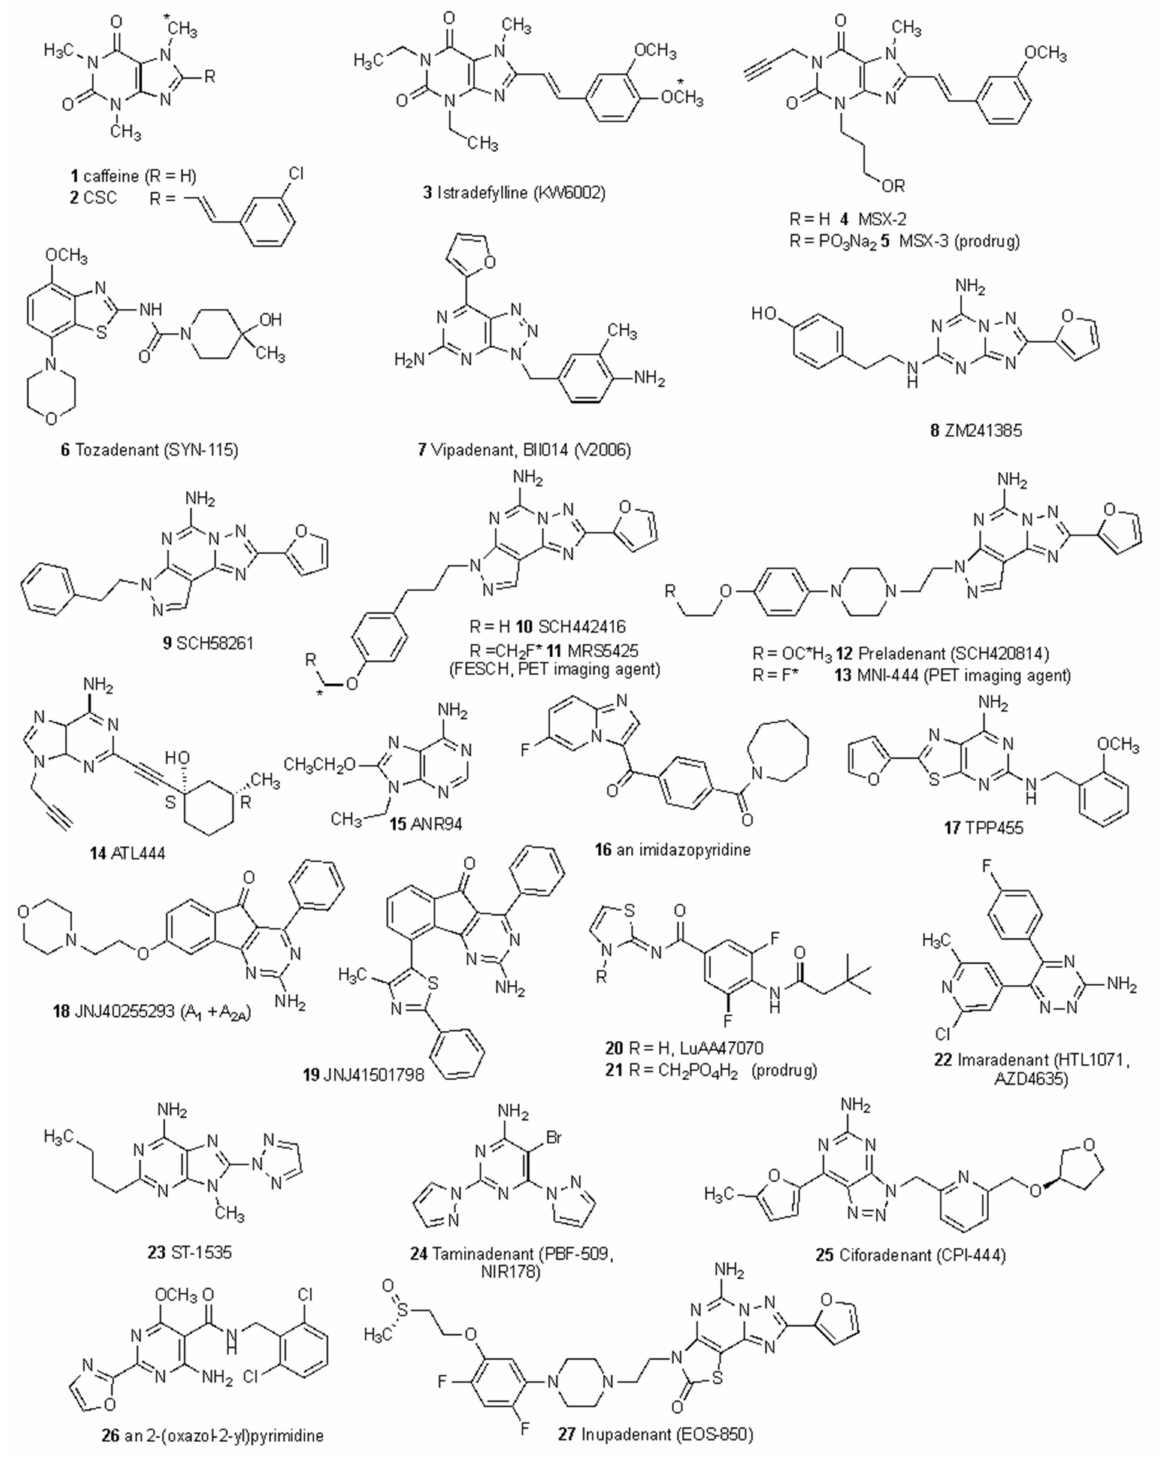
Figure 2. Structures of representative A 2A receptor antagonists 1 – 27 , including those listed in Table 1. Some of these pharmacological probes and clinical candidate compounds have been radiolabeled for PET. Other compounds not listed in Table 1 are described in the literature [67–69]. Additional dedicated PET ligands are shown in Figure 3. Compound 26 is one of a series of A 2A antagonists discovered by AdoRx Therapeutics [68]. * Indicates the location of a positron emitting isotope ( 11 C or 18 F) when used as a PET tracer